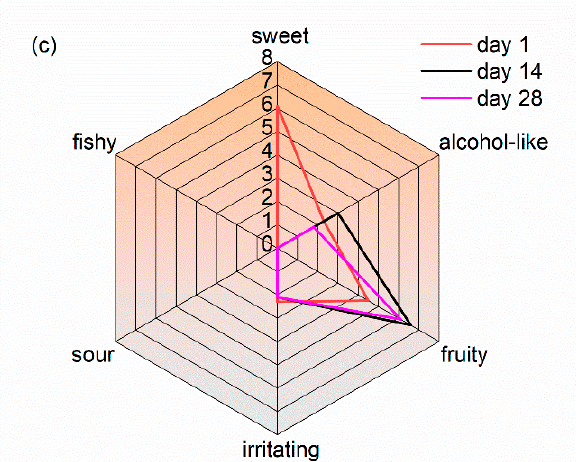
Figure 3. The odor profile spectra of WB-MDF at different testing times. ( a ) the odor profile spectra on days 1, 3, 7; ( b ) the odor profile spectra on days 14, 21, 28; ( c ) the variability of odor profile spectra on days 1, 14,